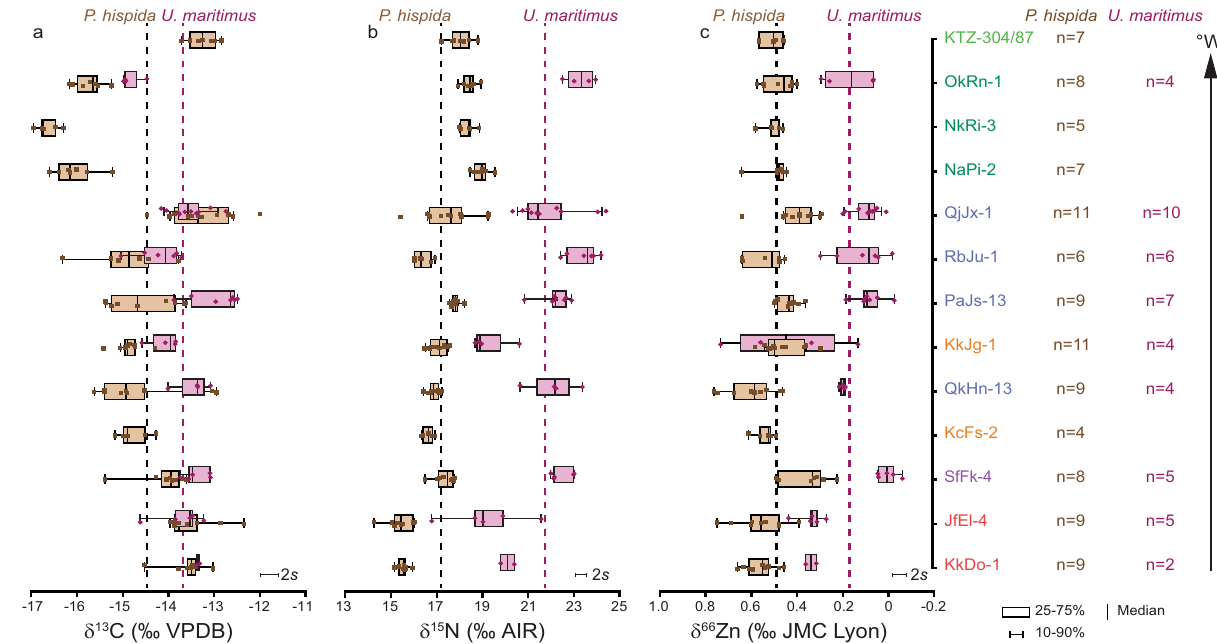
Fig. 2 Range of δ 13 C, δ 15 N and δ 66 Zn values for P. hispida and U. maritimus bones. Range of δ 13 C ( a ), δ 15 N ( b ) and δ 66 Zn ( c ) values for P. hispida and U. maritimus bones for all locations. Site names are colour coded following Fig. 1. Dashed lines represent mean values when including all sites. We included already published δ 15 N and δ 13 C values from sites RbJu-1, PaJs-13, QkHn-13, KTZ and QjJx-1 sites 4,15,30,31 and already published δ 66 Zn values from QjJx-1 15 . Error bars represent the measurement